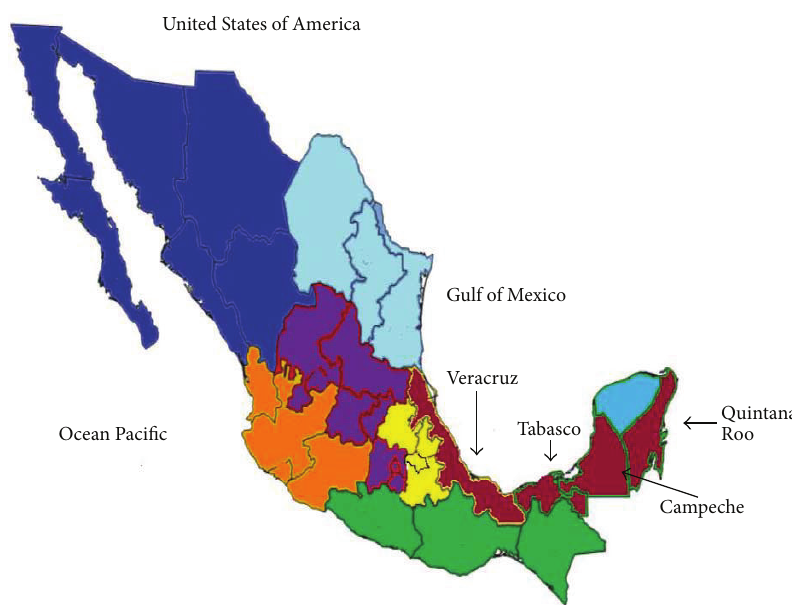
Figure 4: Map of Mexico, showing the endemic regions studied in this work, Veracruz, Tabasco, Campeche, and Quintana